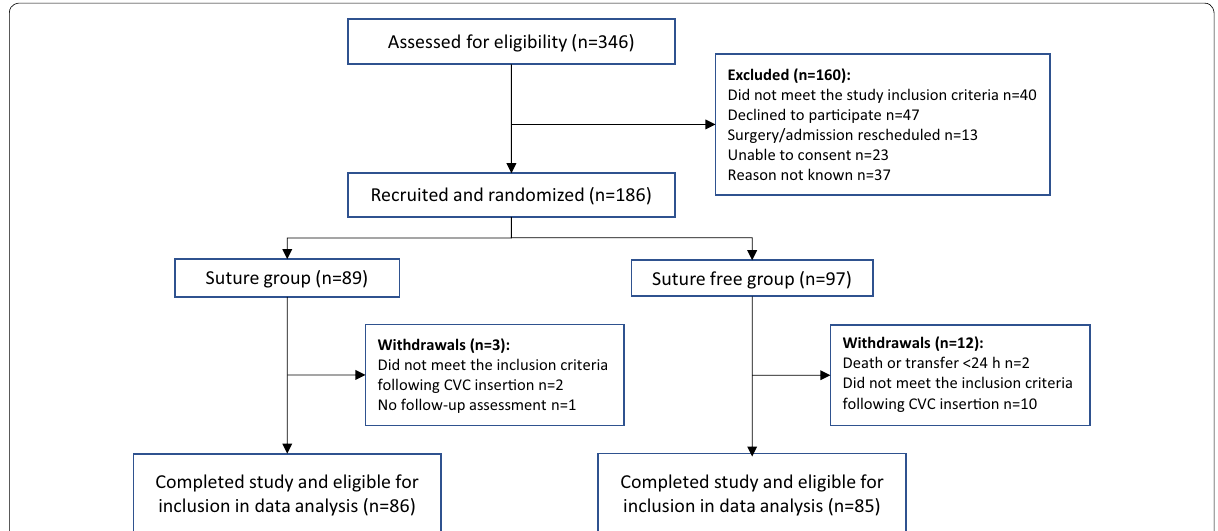
Fig. 2 Study CONSORT flow diagram. Critical care patients in four study centres were screened and enrolled patients randomized to